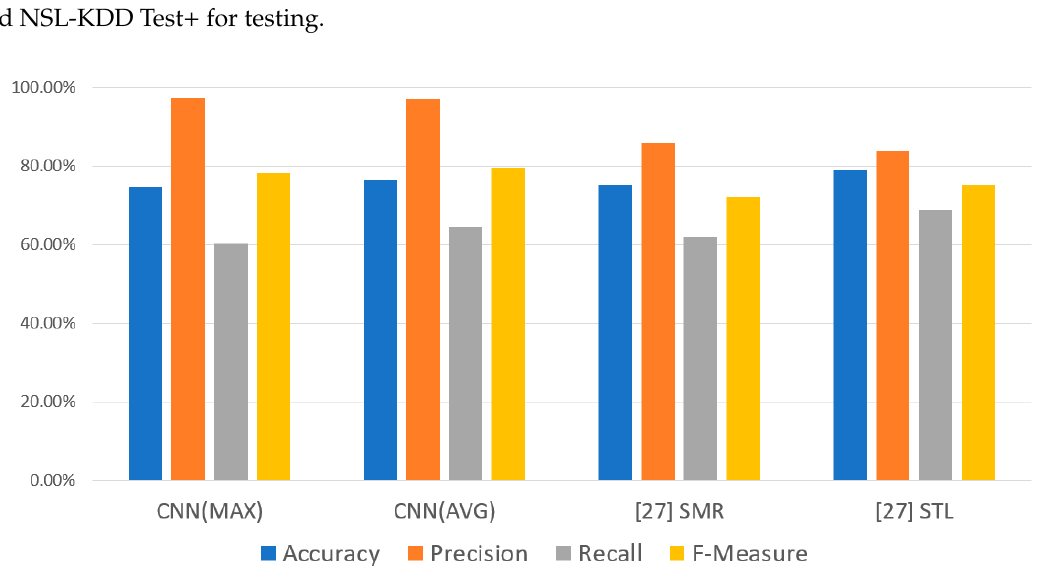
Figure 3. Performance comparison with non-modified NSL-KDD.